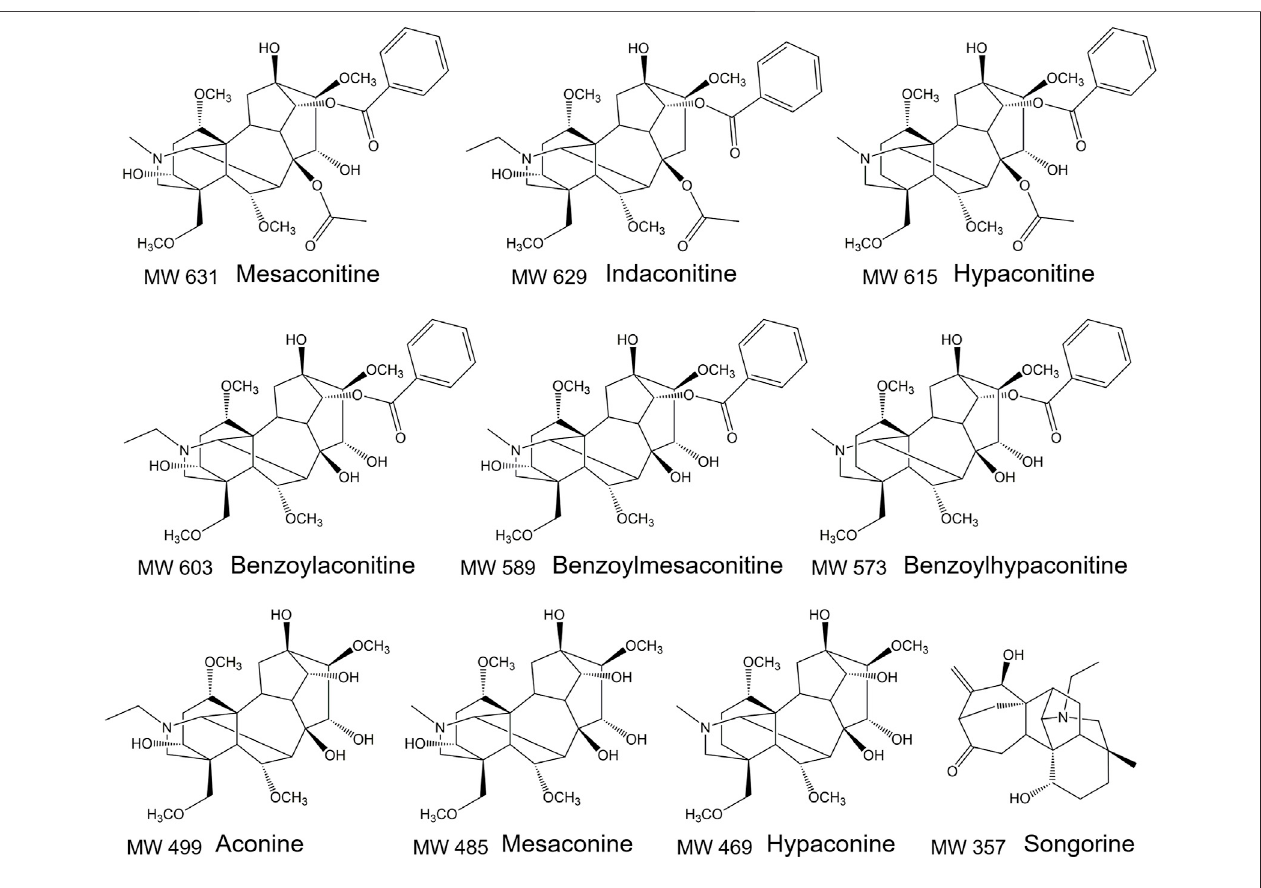
FIGURE 1 | The structure of 10